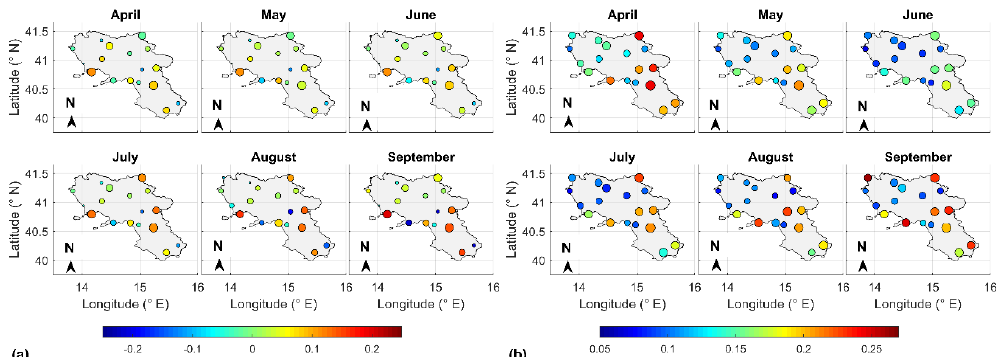
Figure 6. Statistical performance of the kriging estimator by cross-validation: ( a ) nBIAS; ( b ) nRMSE. The indicators are normalized by the observed monthly mean value of ET 0 at the automatic weather station (AWS) site of interest (Table 2) to allow comparison. Marker size is proportional to the value p 75 + 1.5(p 75 − p 25 ) where the 25th (p 25 ) and 75th (p 75 ) percentiles are related to the interannual variability of the statistics. The monthly statistical indicators are represented according to the color scale on the bottom.